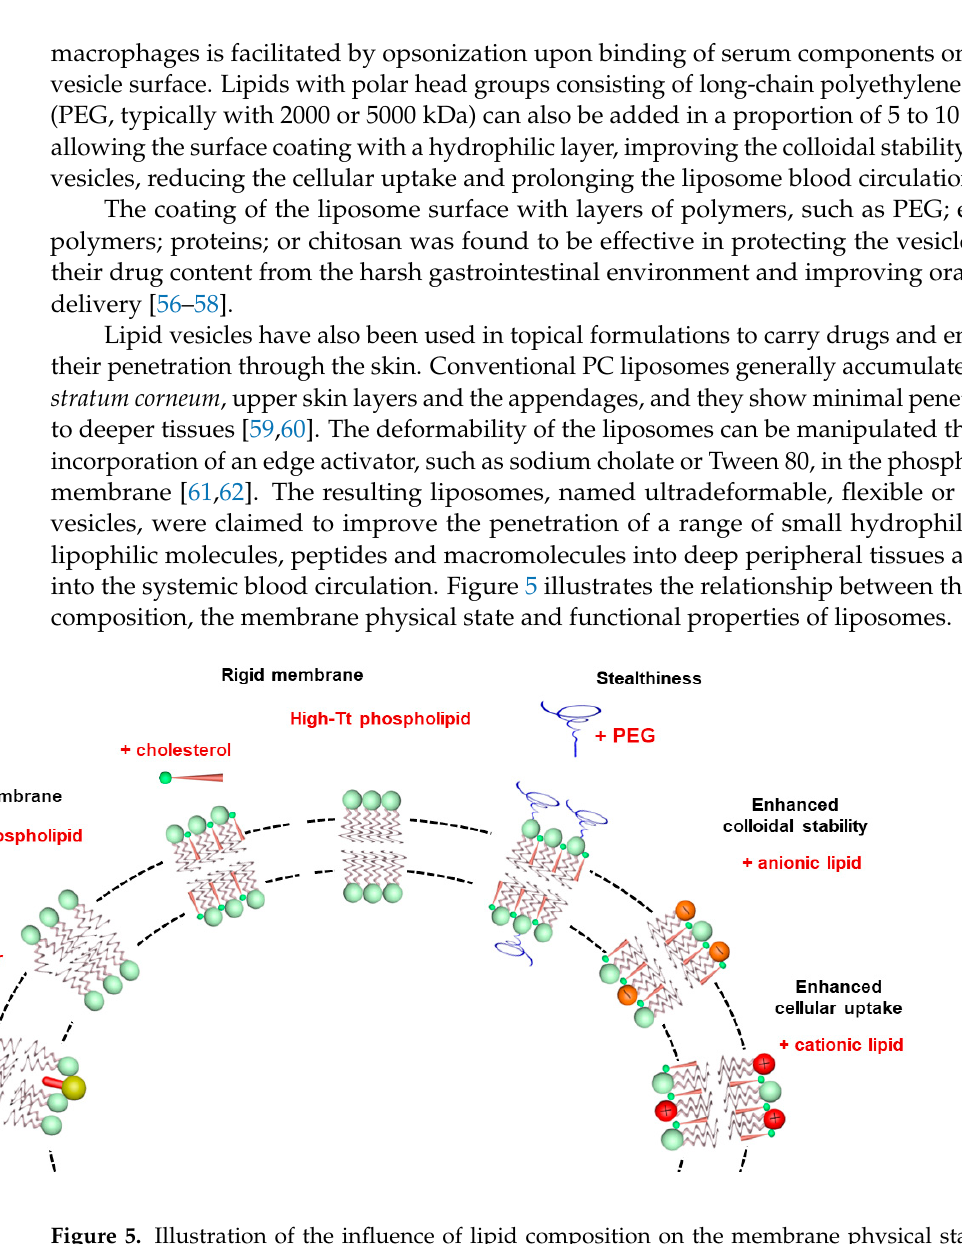
Figure 5. Illustration of the influence of lipid composition on the membrane physical state and functional properties of liposomes.